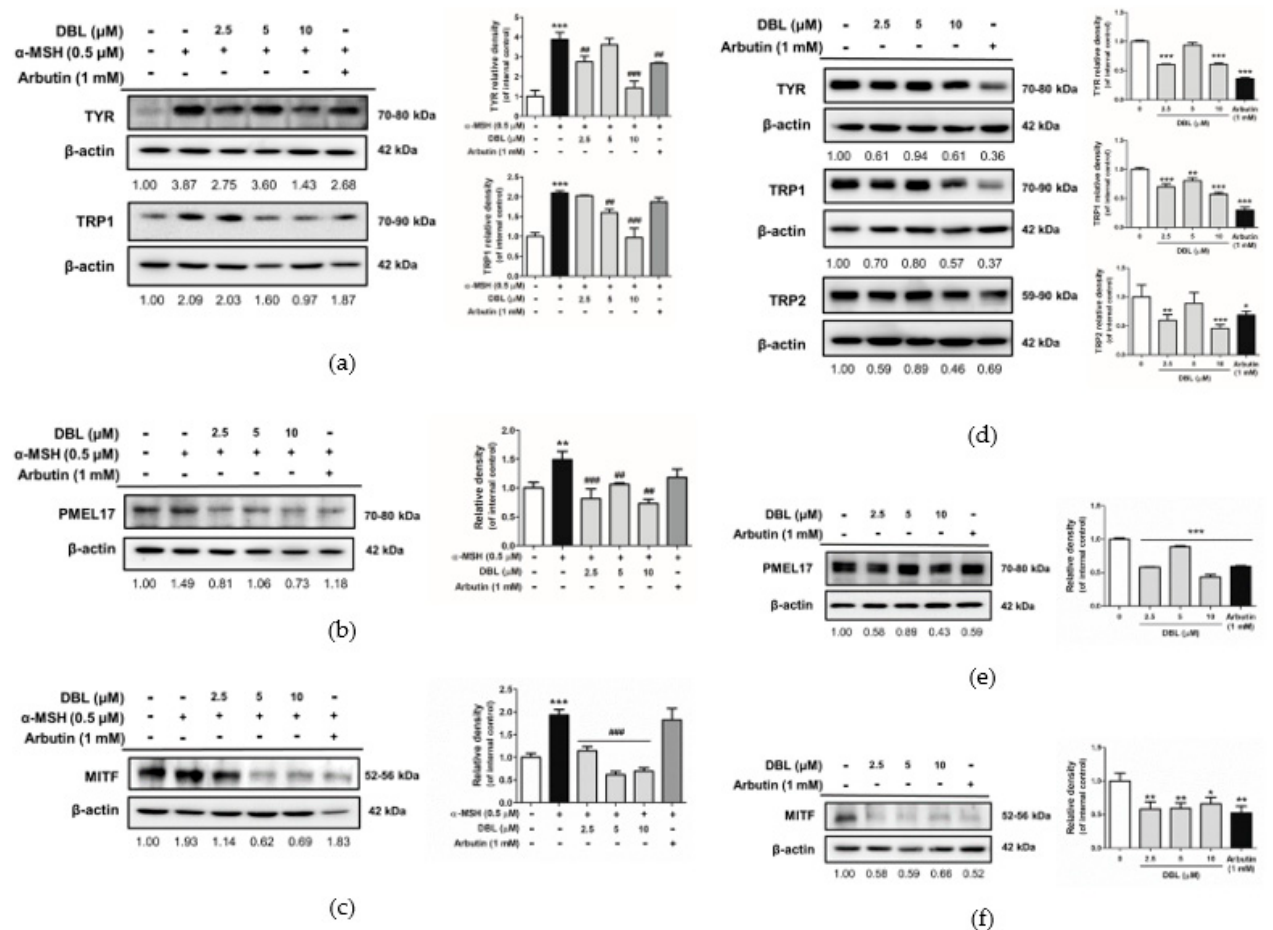
Figure 4. The expression of signaling molecules and melanogenic enzymes, in response to the effect of DBL in α -MSH-induced B16F10 and HEMs. Western blot analysis of the expression of ( a ) tyrosinase (TYR), tyrosinase-related protein-1 (TRP-1), ( b ) premelanosome protein 17 (PMEL17), and ( c ) microphthalmia-related transcription factor (MITF) in DBL-treated and α -MSH-induced B16F10 for 48 h. Western blot analysis of the expression of ( d ) TYR, TRP-1, tyrosinase-related protein-2 (TRP-2), ( e ) PMEL17, and ( f ) MITF in DBL-treated HEMs for 72 h. Inserted values indicated relative protein expression in comparison with β -actin. All data have been presented as mean ± SD. Significant difference versus control group: * p < 0.05, ** p < 0.01, *** p < 0.001. Significant difference versus α -MSH-treated group: # p < 0.05, ## p < 0.01, ### p < 0.001. Positive control: 1 mM arbutin.